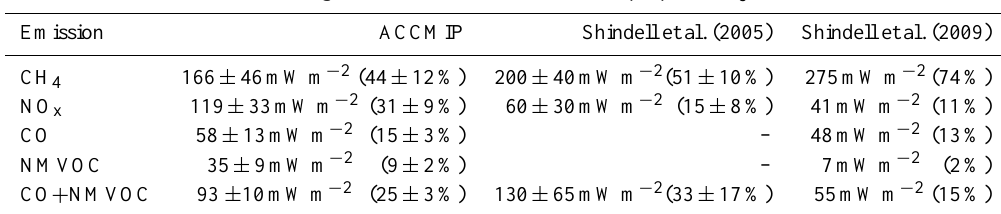
Table 11. Contributions of emissions of CH 4 , NO x , CO and NMVOC to the 1850–2000 CH 4 RF (mW m − 2 ) , for this study, and also from Shindell et al. (2005, 2009). The Shindell et al. (2005, 2009) values are all for 1750–2000, and were calculated with a different methodology. The ACCMIP values are the means and standard deviations of the six models in Table 8. The Shindell et al. (2005) values have estimated errors of ± 20% for CH 4 and ± 50% for other